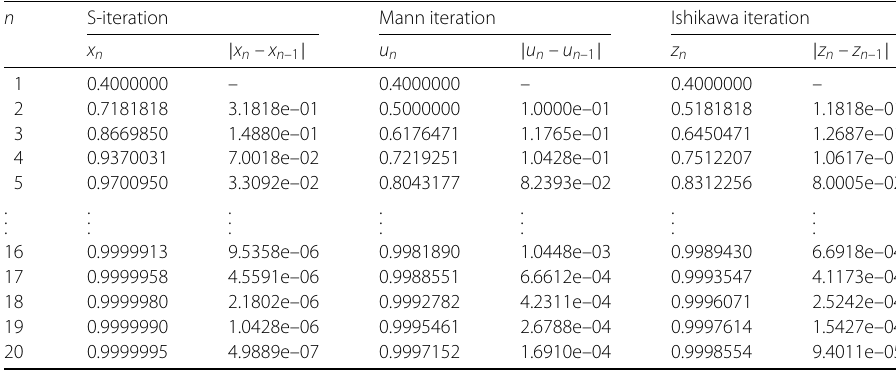
Table 2 Iterates of S-iteration, Mann iteration, and Ishikawa iteration for x 1 = u 1 = z 1 =